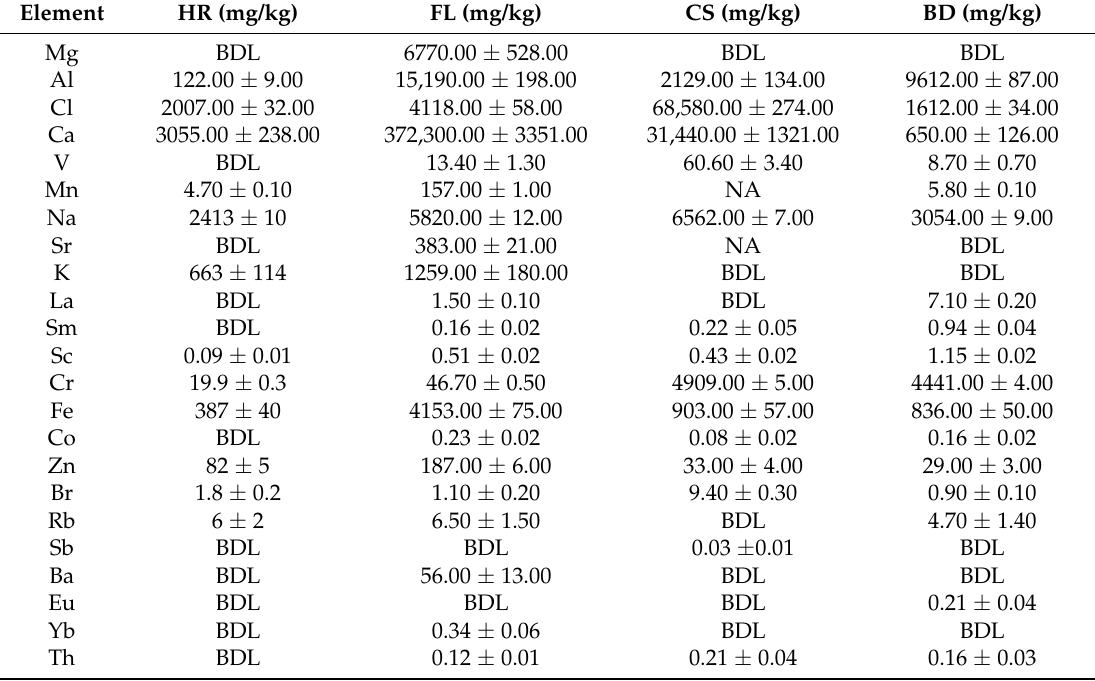
Table 1. Ultimate Analysis of Pretreated Waste Samples